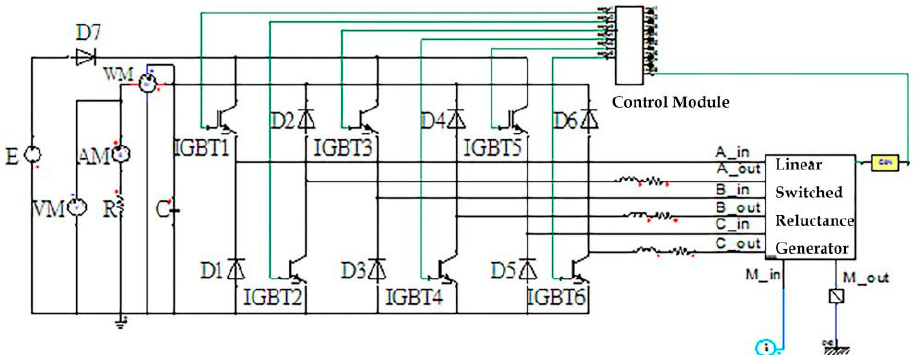
Figure 7. The DLSRG joint simulation system is mainly composed of excitation power supply, motor module, main circuit and control module as shown in Figure 7.